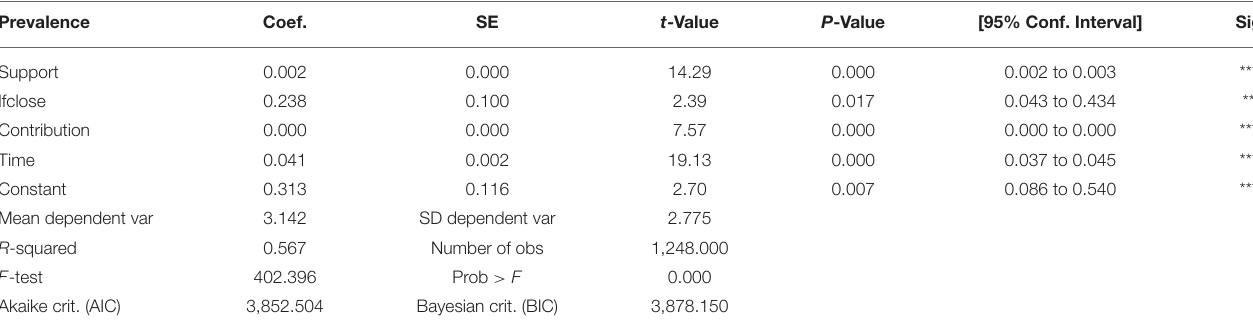
Constant Mean dependent